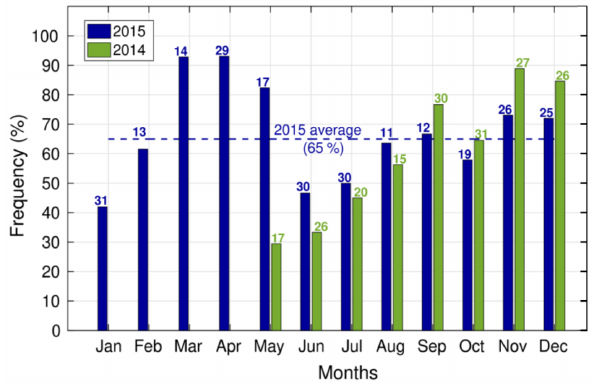
Figure 5. Monthly event frequency (%) variation during 2014 (green) and 2015 (blue). Values at the top of the bars correspond to the number of days that were taken into account for